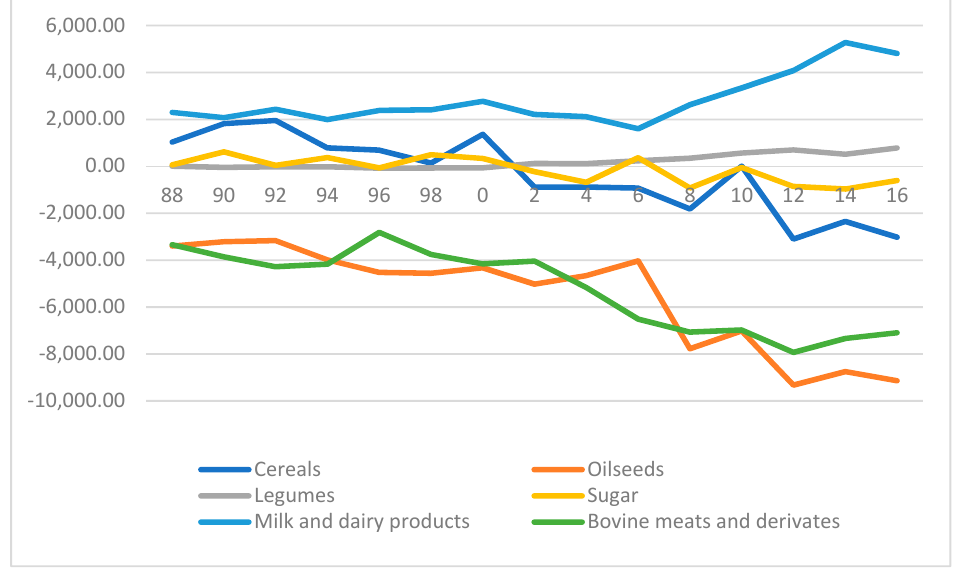
Figure 7. Foreign trade balance for continental products (millions of euros, current prices). Source: own elaboration based on data obtained from EUROSTAT.